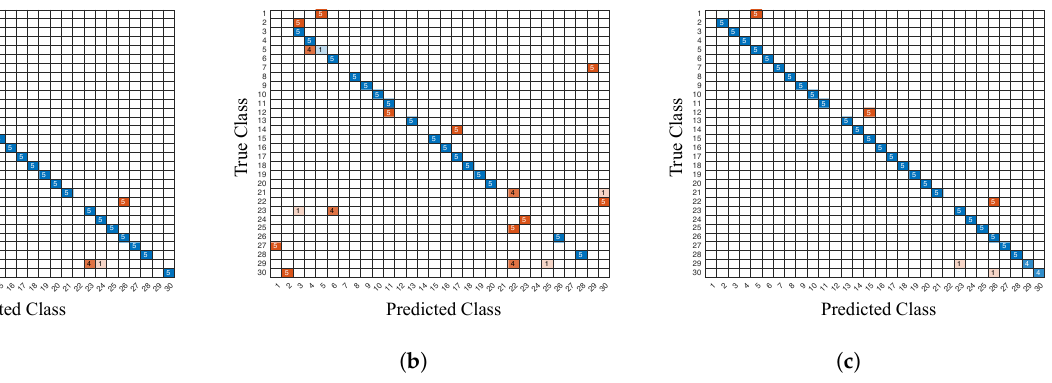
Figure 16. Confusion matrix for KNN methods with different smartphones. ( a ) iPhone Xs Max. ( b ) Huawei P9. ( c ) Bluebird. Table 5. Accuracy comparison of homogeneous devices with different positioning methods.